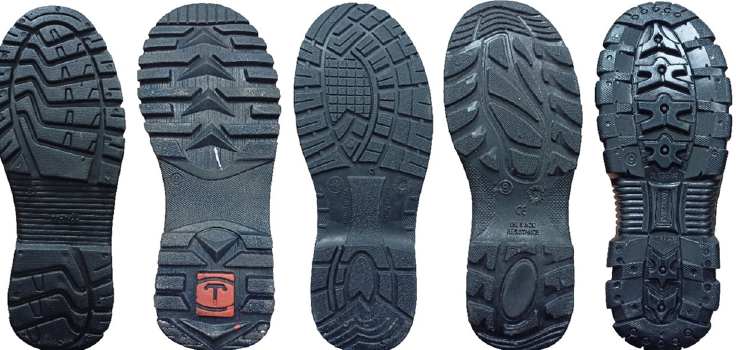
Figure 2. Shoes selected for this study. From the left to right: Safety Shoe 1 (SS1); Safety Shoe 2 (SS2); Safety Shoe 3 (SS3); Safety Shoe 4 (SS4); Safety Shoe 5 (SS5).